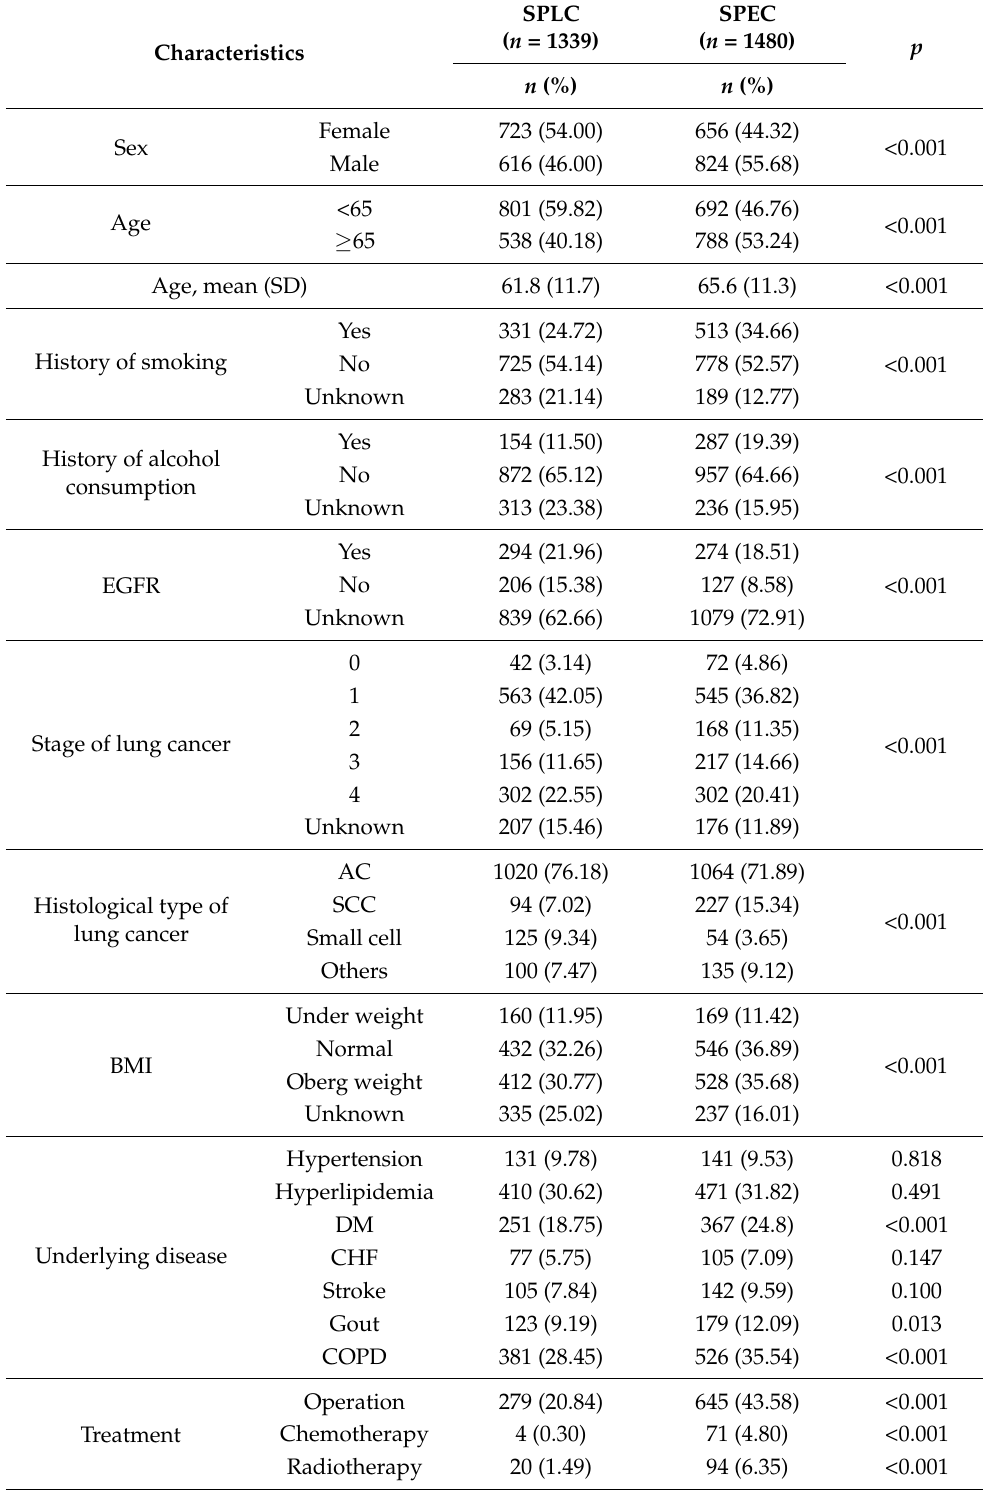
Table 3. A comparison of the characteristics between the SPLC and SPEC groups.